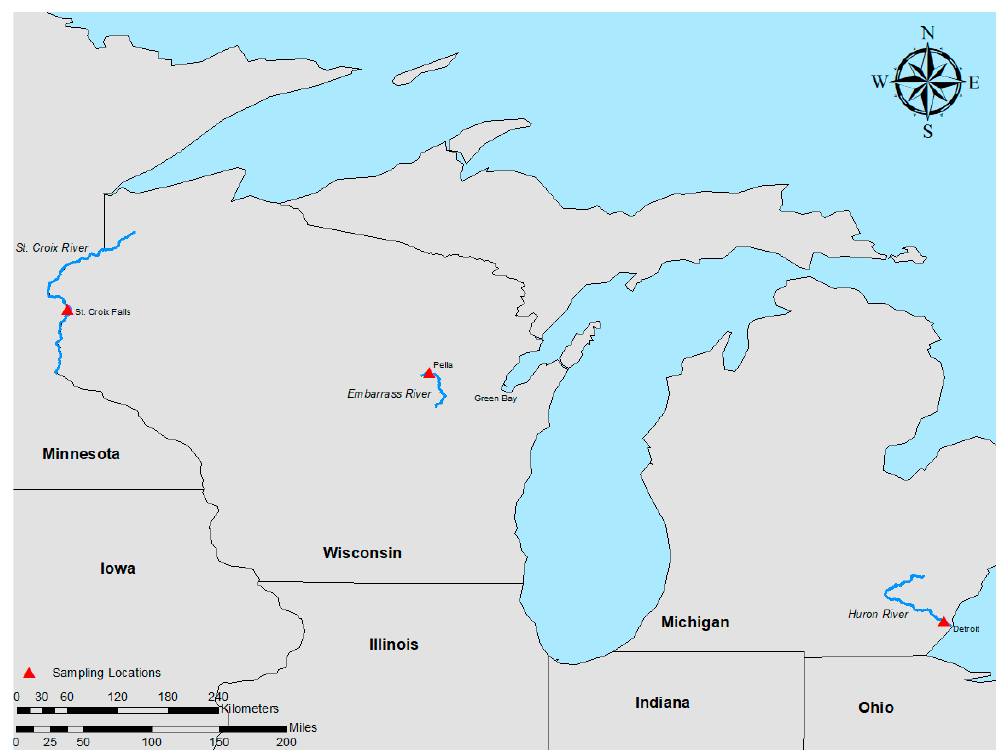
Figure 1. Map of sampling locations, which includes the Huron River (MI), Embarrass River (WI), and St. Croix River (WI).